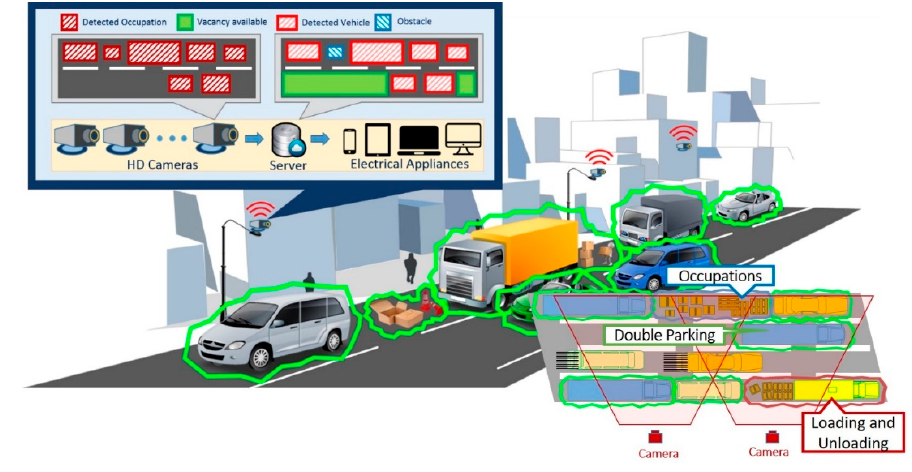
Figure 2. Overview of the CVROSS.